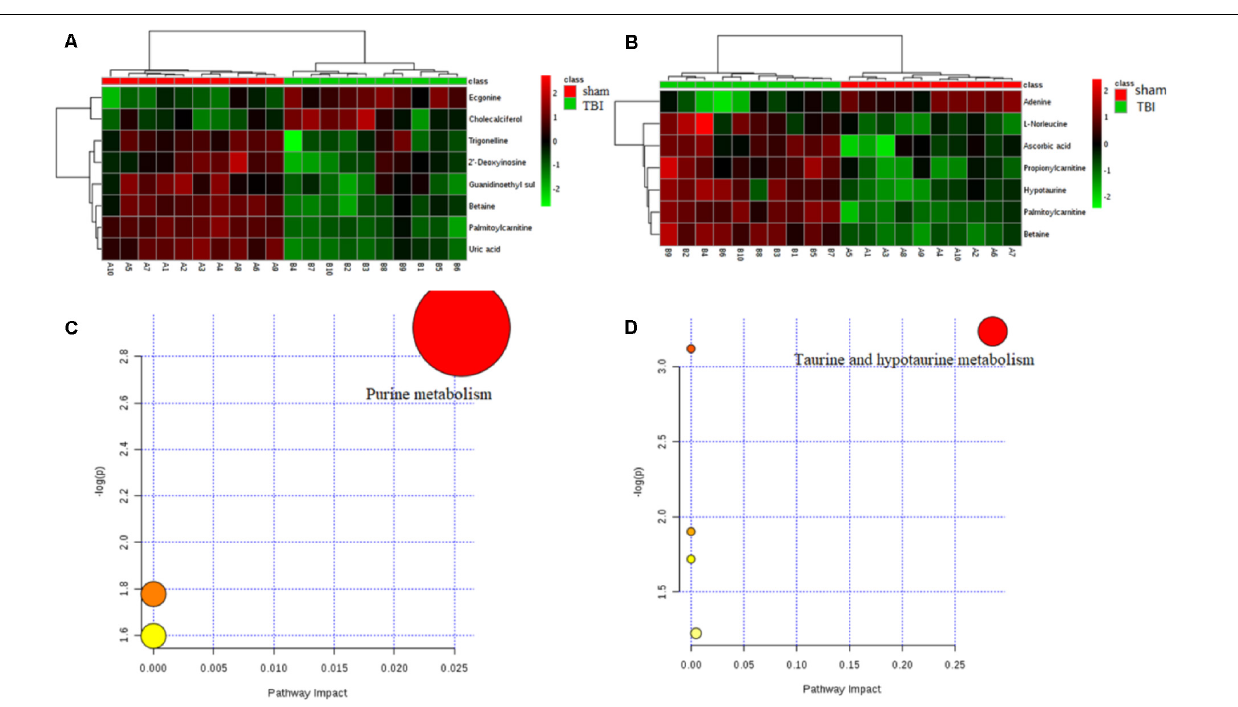
FIGURE 6 | Results of heat maps and enrichment analysis of pathways. In the heat maps, the green color represents downregulation and the red color represents upregulation. For a metabolome view of the pathways, the colors of the nodes are determined based on the P -value of the pathway, and the radii are based on the impact values of their pathways. (A) Heat map of different metabolites in traumatic brain injury (TBI) of the cortex. (B) Heat map of different metabolites in TBI of the hippocampus. (C) Disturbed metabolic pathway associated with TBI of the cortex on day 7. (D) Disturbed metabolic pathway associated with TBI of the cortex on day